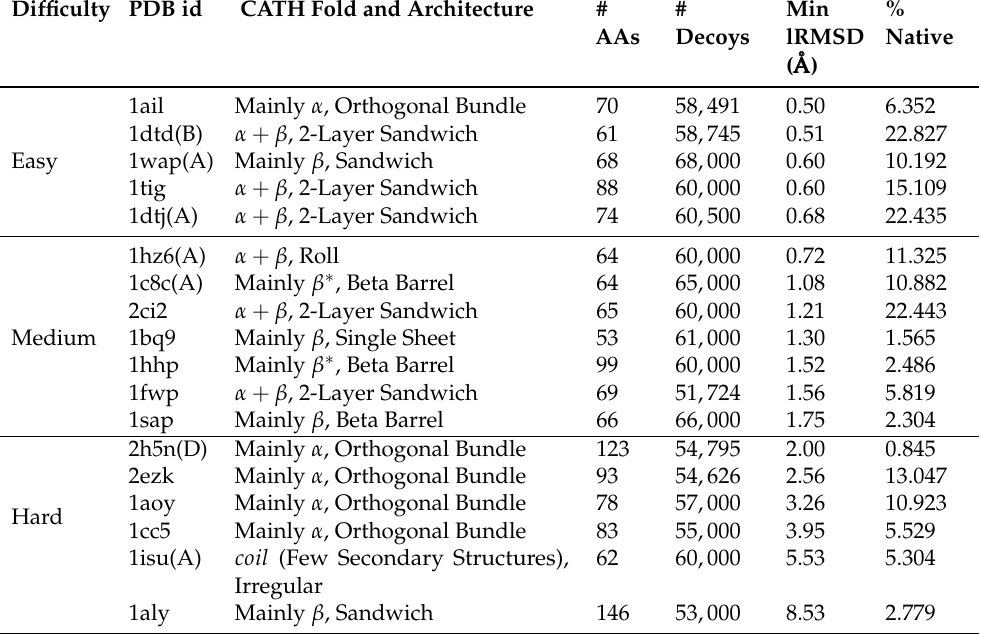
Table 1. Testing dataset (* denotes proteins with a predominant β fold and a short helix). The chain extracted from a multi-chain PDB entry (shown in Column 2) to be used as the native structure is shown in parentheses. The CATH fold and architecture [41] of the known native structure is shown in Column 3. The length of the protein sequence (#aas) is shown in Column 4. The size of the Rosetta-generated decoy dataset is shown in Column 5. Column 6 shows the minimum lRMSD over decoys from the known native structure. Column 7 shows the percentage of near-native decoy structures (within some threshold lRMSD of the known native